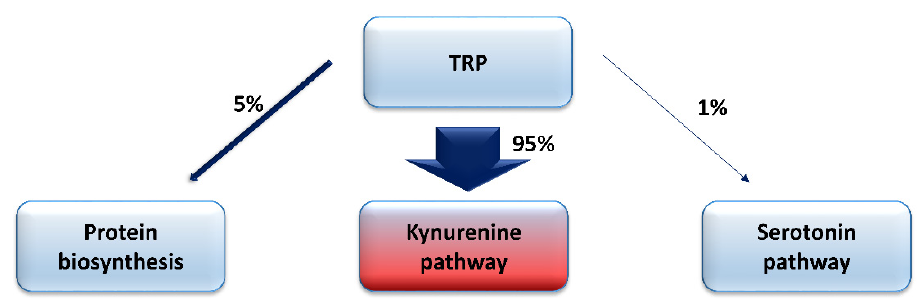
Figure 1. The main pathways of tryptophan (TRP) metabolism.